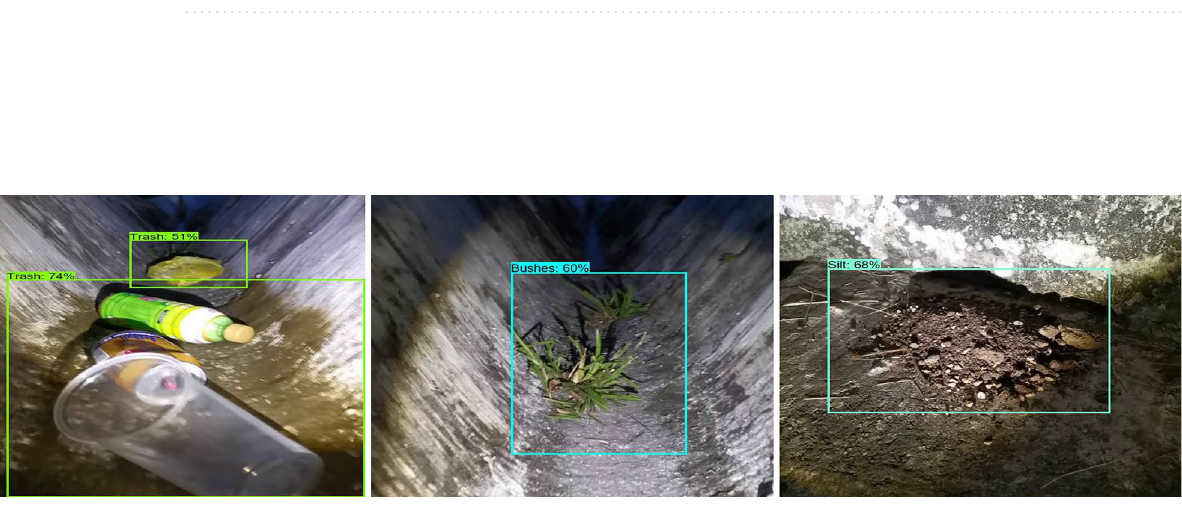
Figure 17. Silt detection on real time drain inspection field test (day).